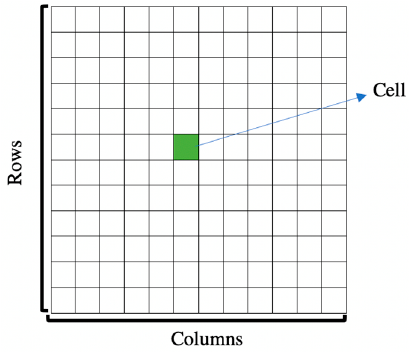
Figure 1. A raster is composed of rows and columns of cells.